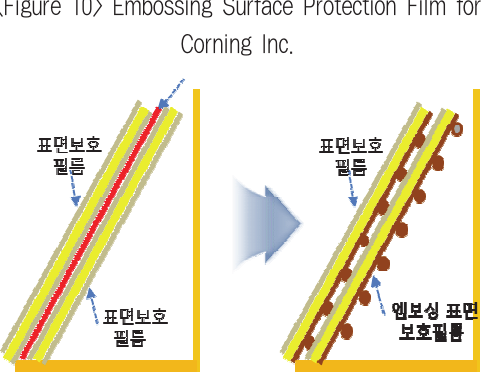
<Figure 10> Embossing Surface Protection Film for Corning